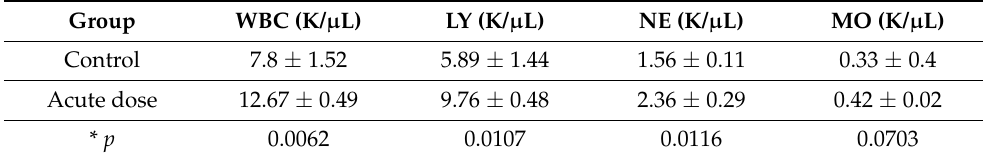
Table 7. Effect of administrating a dose of 2000 mg/Kg of nutraceutical on the total numbers of leukocytes (WBC), lymphocytes (LY), neutrophils (NE) and monocytes (MO) in mice—acute toxicity testing; * p = p